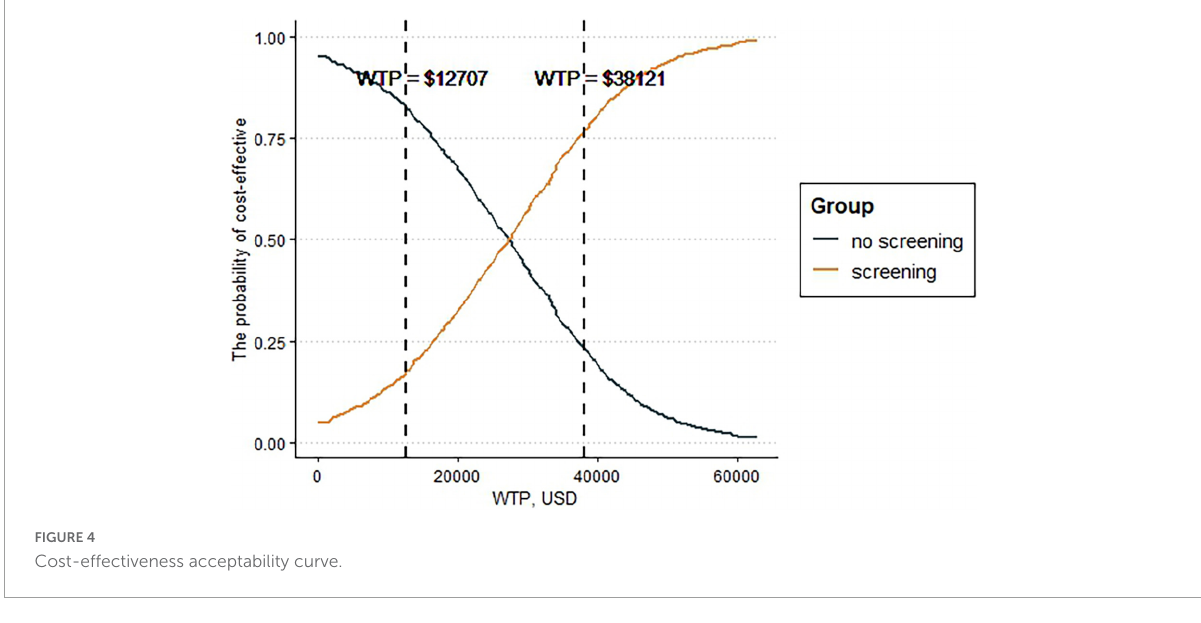
TABLE 6 Results of scenario